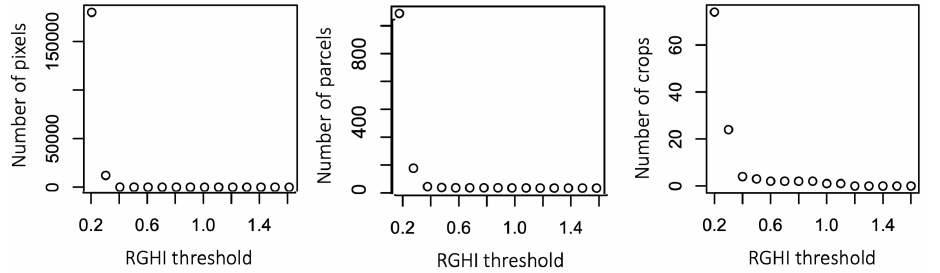
Figure 14. RPGI threshold intervals and the corresponding pixels attributed to greenhouses in Sentinel-2 images of 20 April